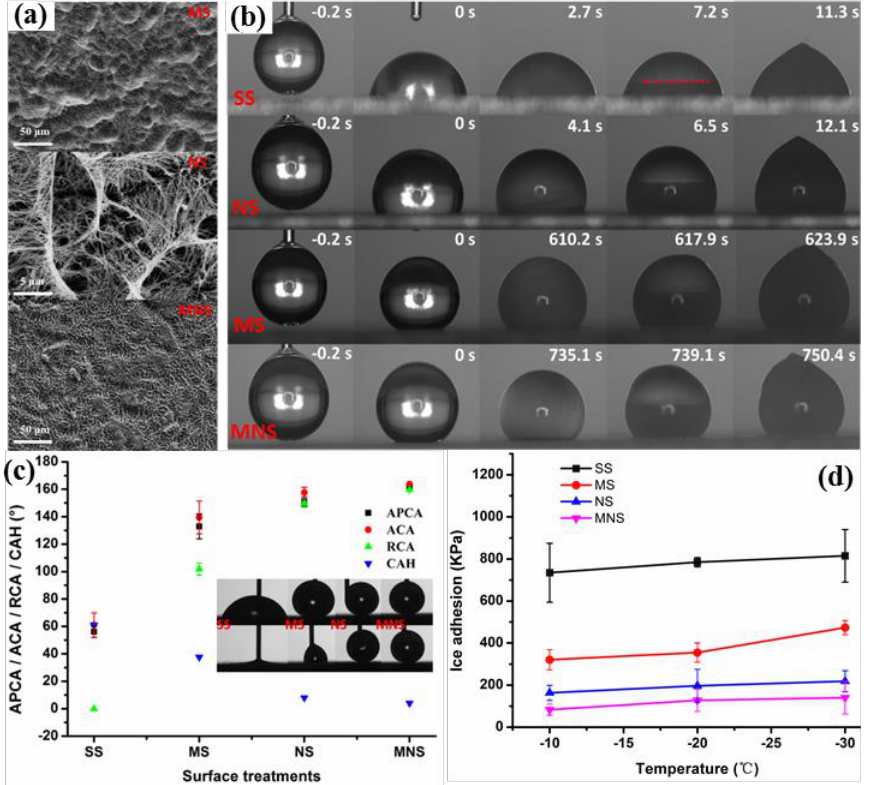
Figure 17. ( a ) Images of hierarchical morphologies and characterization results of the wettability of SS, MS, NS, and MNS; ( b ) Optical images show the icing process of 4 μL water droplets on SS, MS, NS, and MNS at −10 °C; ( c ) APCA, ACA, RCA, and CAH of water droplets on SS, MS, NS, and MNS; and ( d ) The relationship between ice adhesion strength and temperature [167]. (Adapted from [167] with permission; Copyright 2015 RSC).